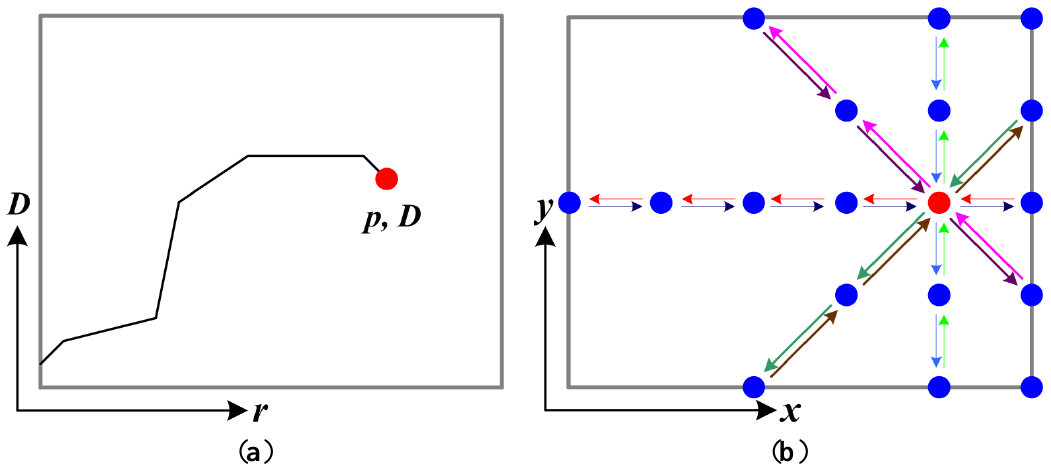
Figure 6. Cost aggregation of SGM: ( a ) minimum cost path in disparity space; and ( b ) eight directions that go through the red pixel p .